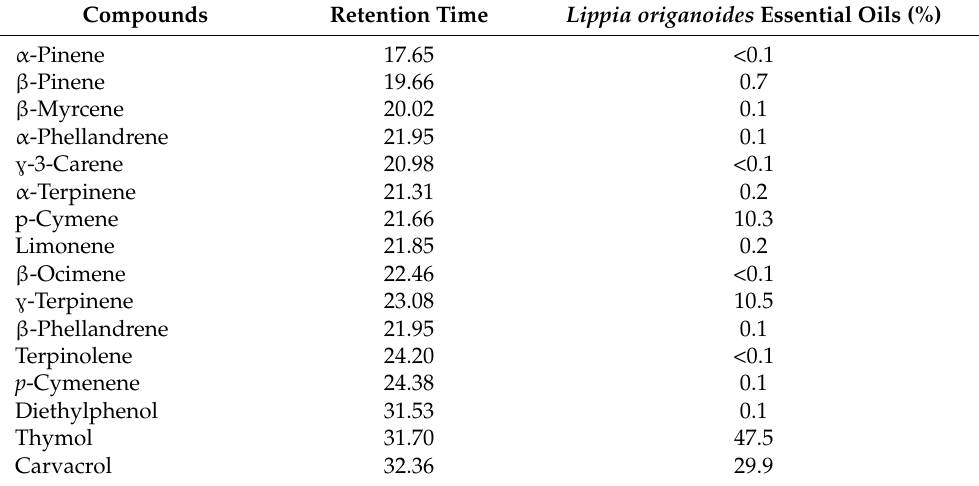
Table 1. Qualitative and quantitative chemical composition of Lippia origanoides essential oils.